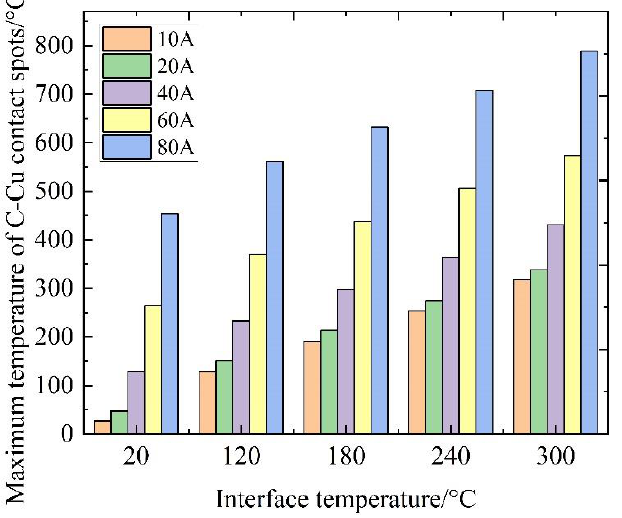
Figure 9. The maximum temperature of the C-Cu contact spots varies with interface temperature under different currents.